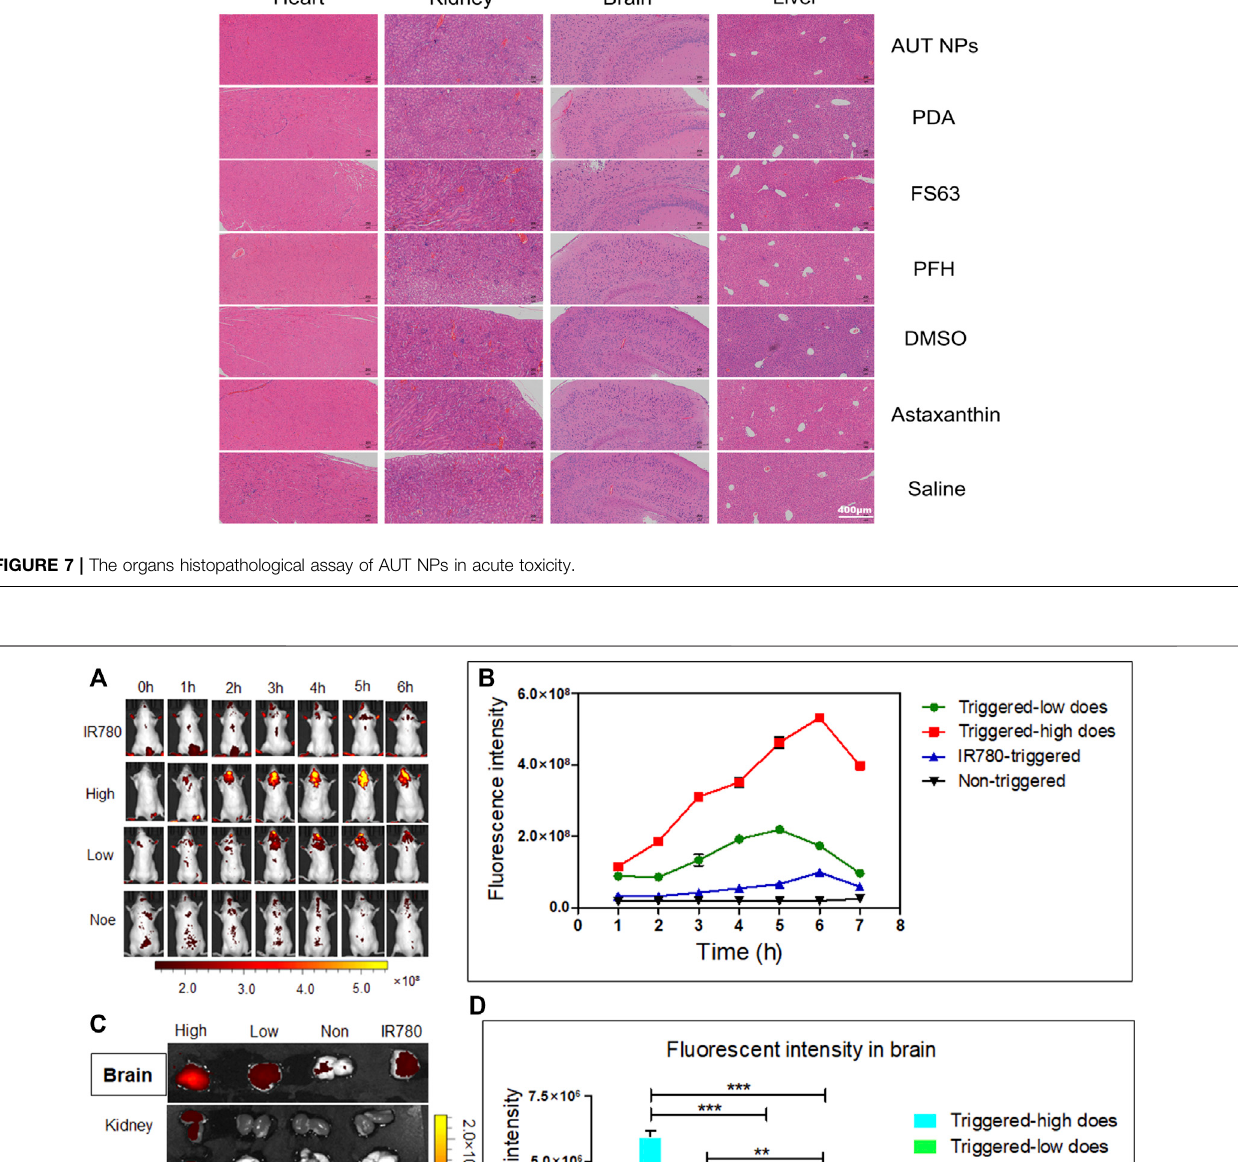
Frontiers in Chemistry |